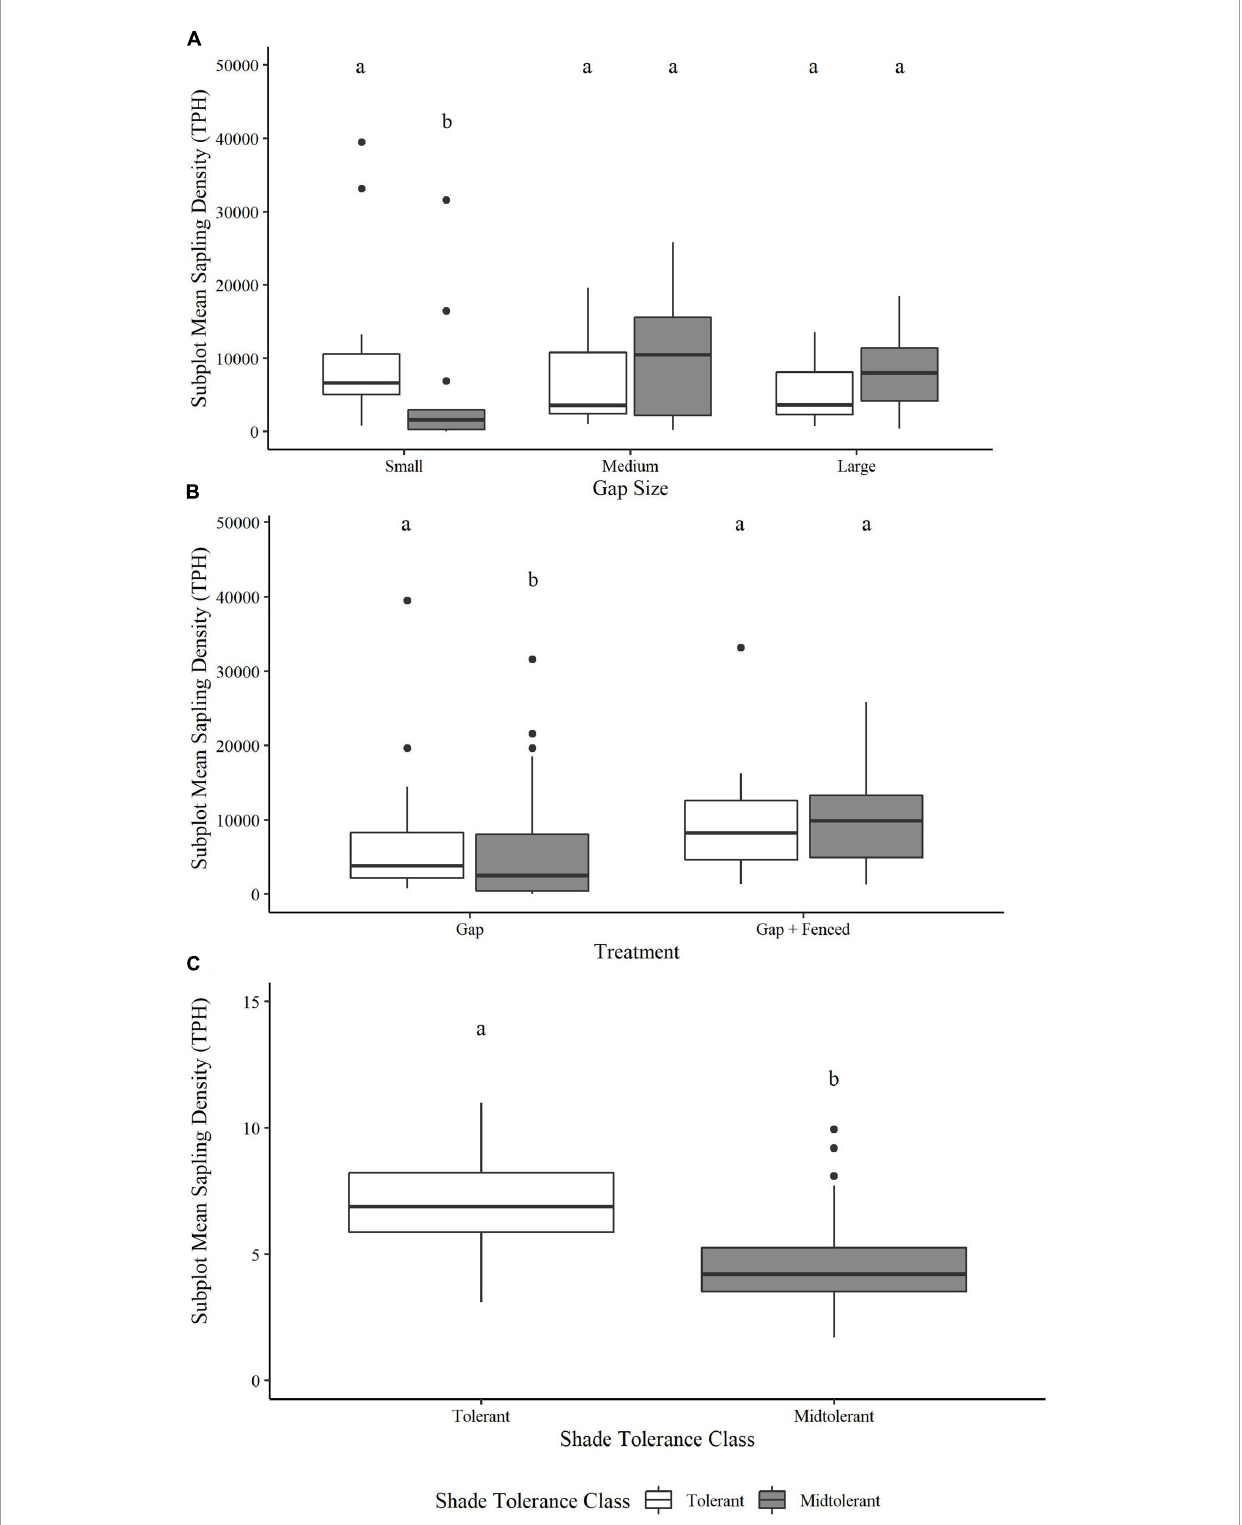
FIGURE5 Pairwise comparisons of the (A) subplot/gap size x shade tolerance class interaction and (B) subplot/gap size x shade tolerance class interaction on subplot-level estimated marginal mean sapling density (TPH) and (C) the fixed effect of shade tolerance class on estimated marginal mean sapling height (m). Boxes not connected by the same letter are significantly different at an α =